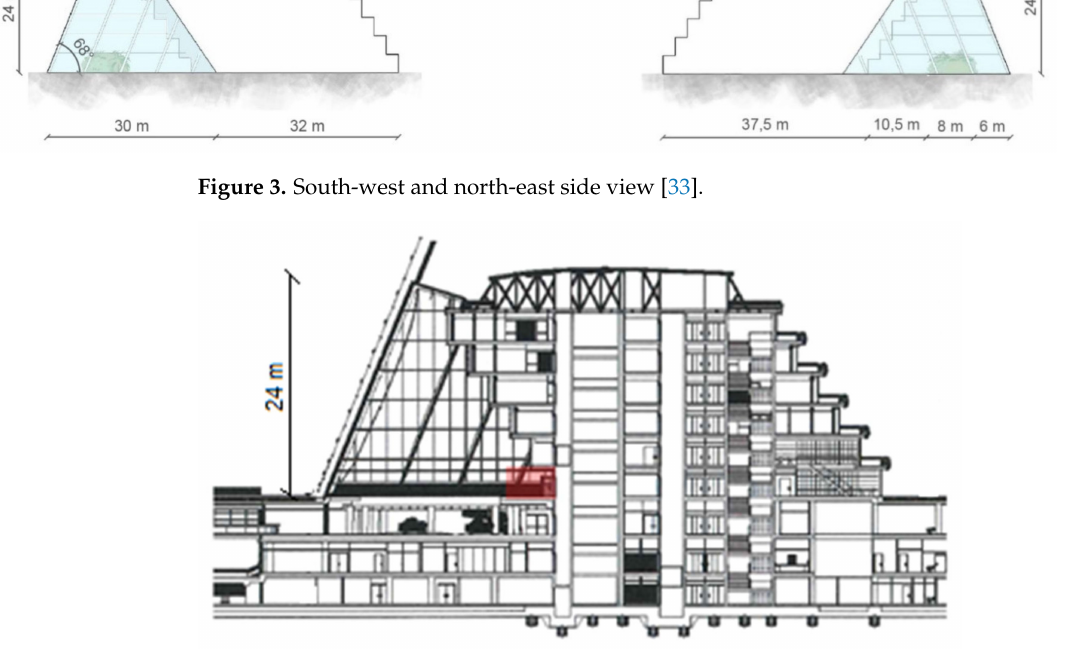
Figure 4. Section south-east north-west of the building (in red the outpatient area).